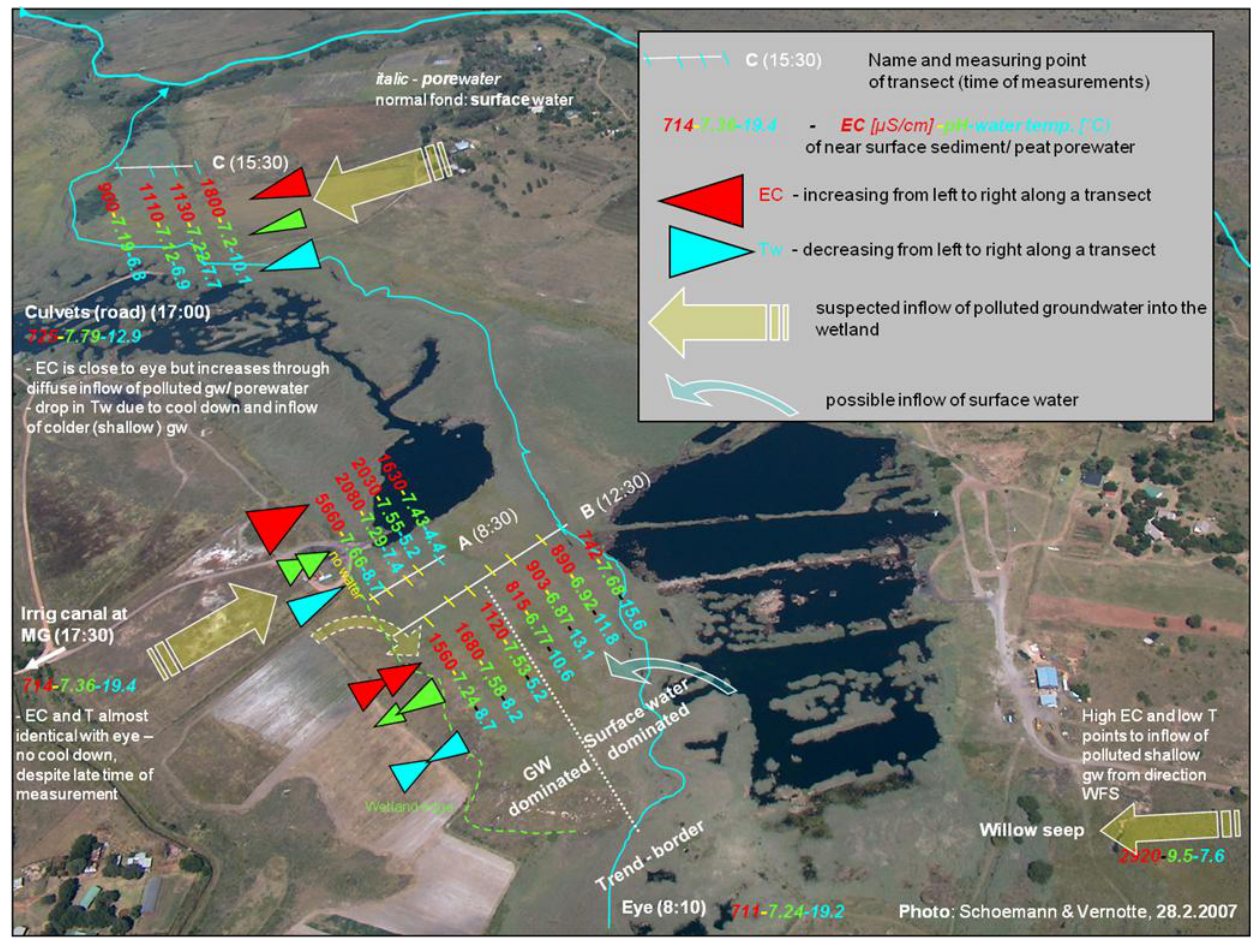
Figure 10. Spatial trends in porewater quality in peat and alluvial sediments as measured in borehole transects at portions 9 and 7, respectively, indicating the influx of polluted groundwater at both sites (12 September 2007, using a multiprobe field